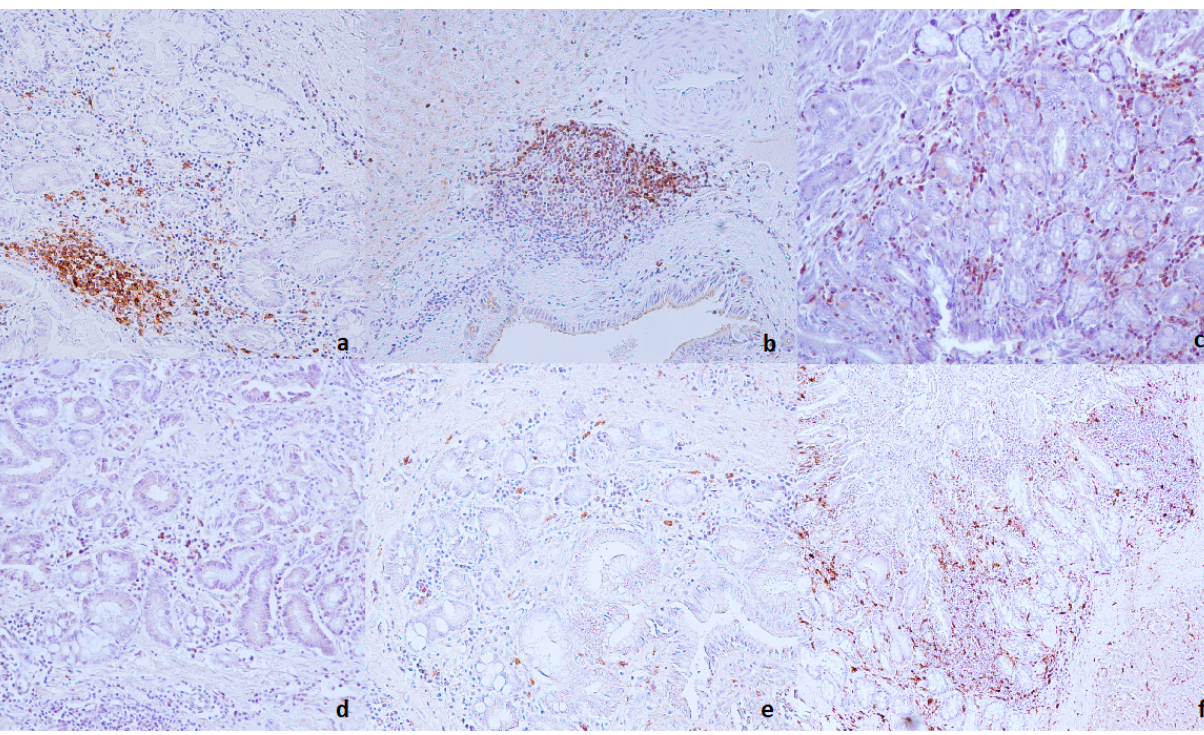
Figure 2. Liver ( a ): Lymphoid aggregate composed of CD79-positive cells associated with a moderate number of CD-79- positive lymphocytes around the hyperplastic bile duct (liver from Group A); ( b ): CD3-positive cells in the periphery of the lymphoid aggregate (liver from Group B); ( c ): CD3+ cells scattered diffusely around the hyperplastic bile ducts (liver from Group C); ( d ): a moderate number of CD8+ cells around the bile ducts (liver from Group A); ( e ): a moderate number of CD4+ cells around hyperplastic bile ducts (liver from Group B) (immunohistochemistry, HRP method, original magnification 200 × ); ( f ): a moderate number of ionized calcium-binding adapter molecule 1 (IBA-1)-positive cells scattered around the bile ducts and within follicular aggregates (liver from Group A) (immunohistochemistry, HRP method, original magnification 100×). Table 2. Results of the immunohistochemical examination.